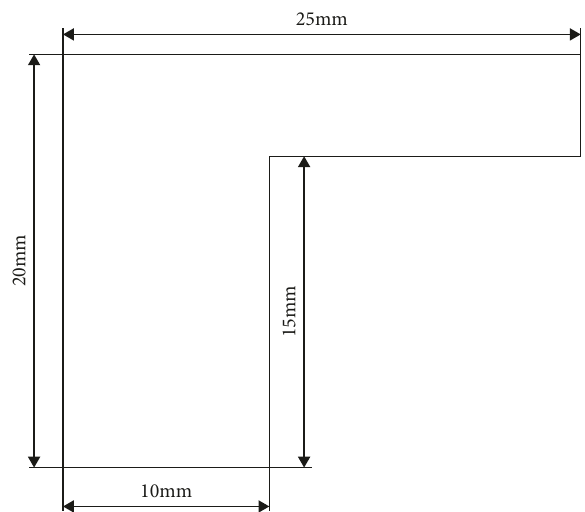
Figure 3: Ledge overhang structure dimensions.